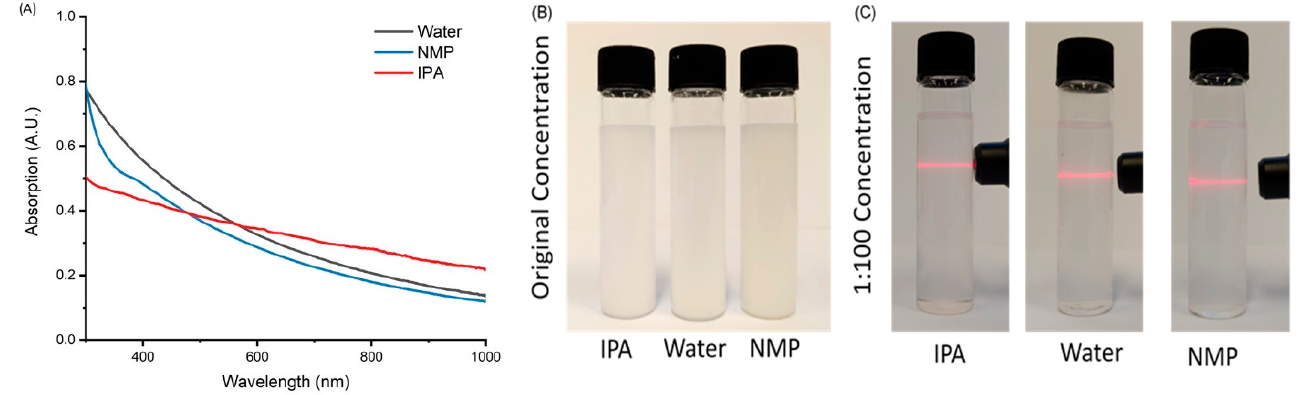
Figure 1. ( A ) UV-Vis spectra of exfoliated BN in NMP (red), IPA (blue) and water (green); ( B ) photograph of original solutions of BN exfoliated in the three solvents (3 mg/mL); ( C ) Tyndall effect on BN exfoliated in IPA, NMP and water (0.03 mg/mL).